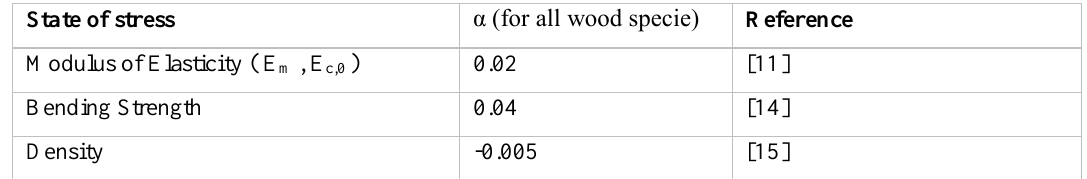
Adjustment factor for Wood state of